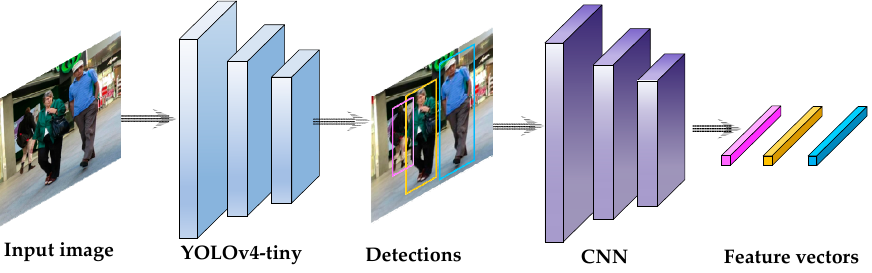
Figure 6. Overview of feature extraction.